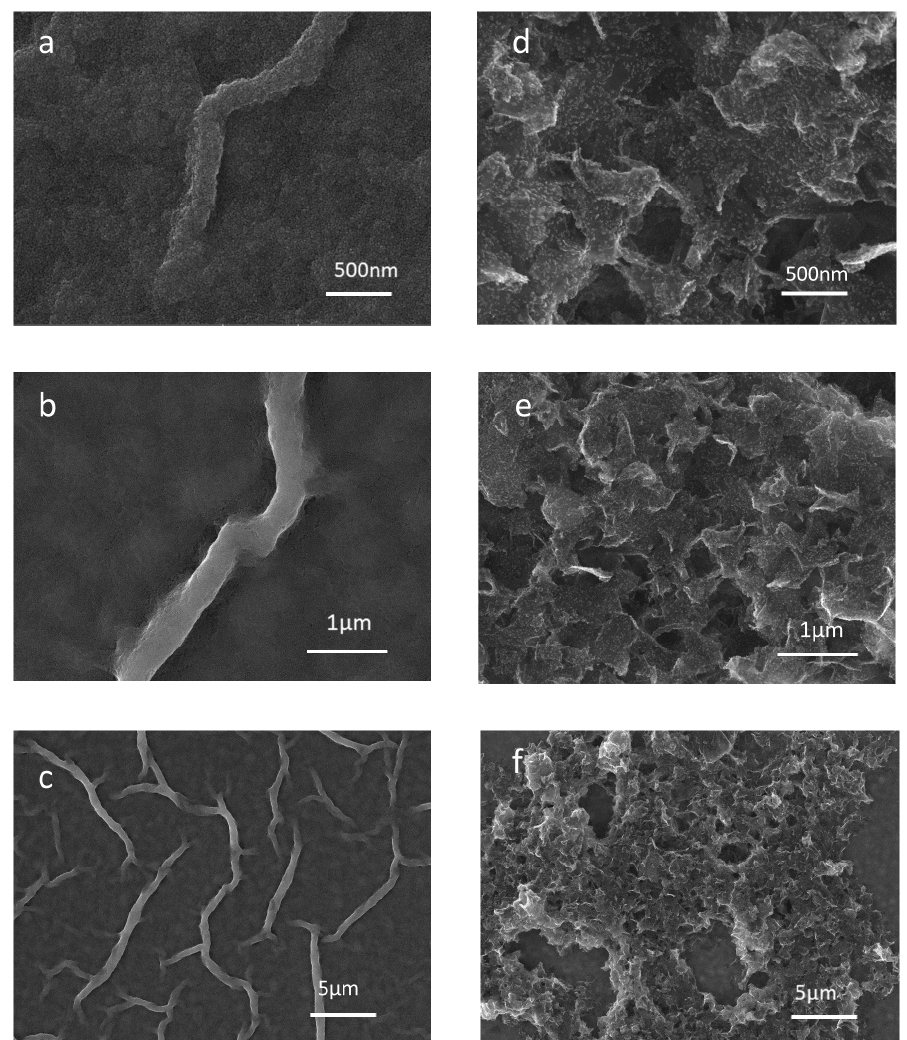
Figure 4. FESEM analysis of grown thin films, ( a – c ) SEM images of ZnO thin film at different magnifications; ( d – f ) GrF/ZnO composite SEM images at various magnifications.